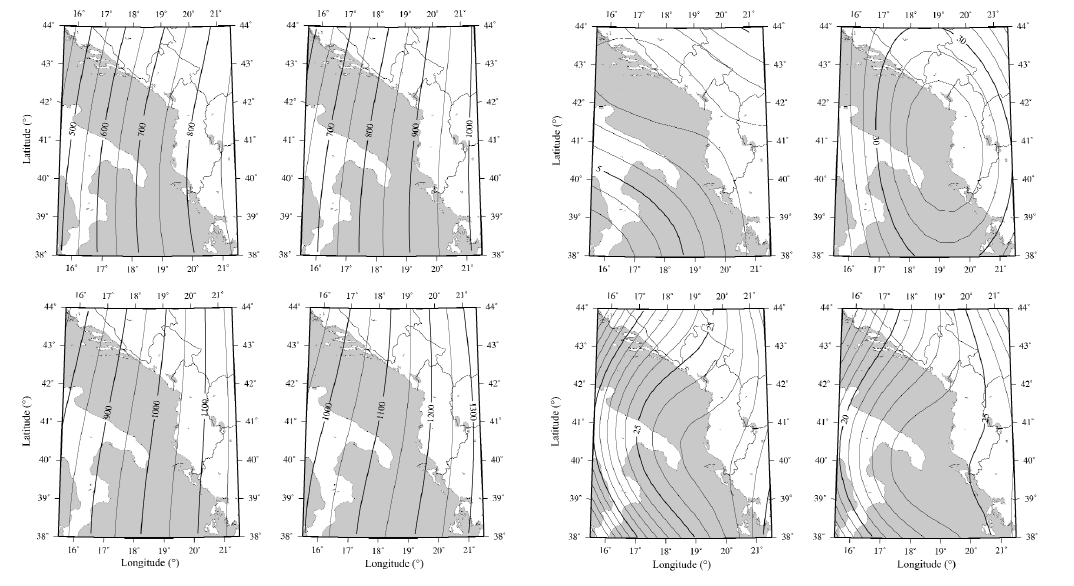
Fig. 5. Maps (in nT) for Y component for epochs 1990.0 (top left), 1995.0 (top right), 2000.0 (bottom left), and 2005.0 (bottom right) at sea level obtained from the SCHA model developed on an 8° semian- gle cap.